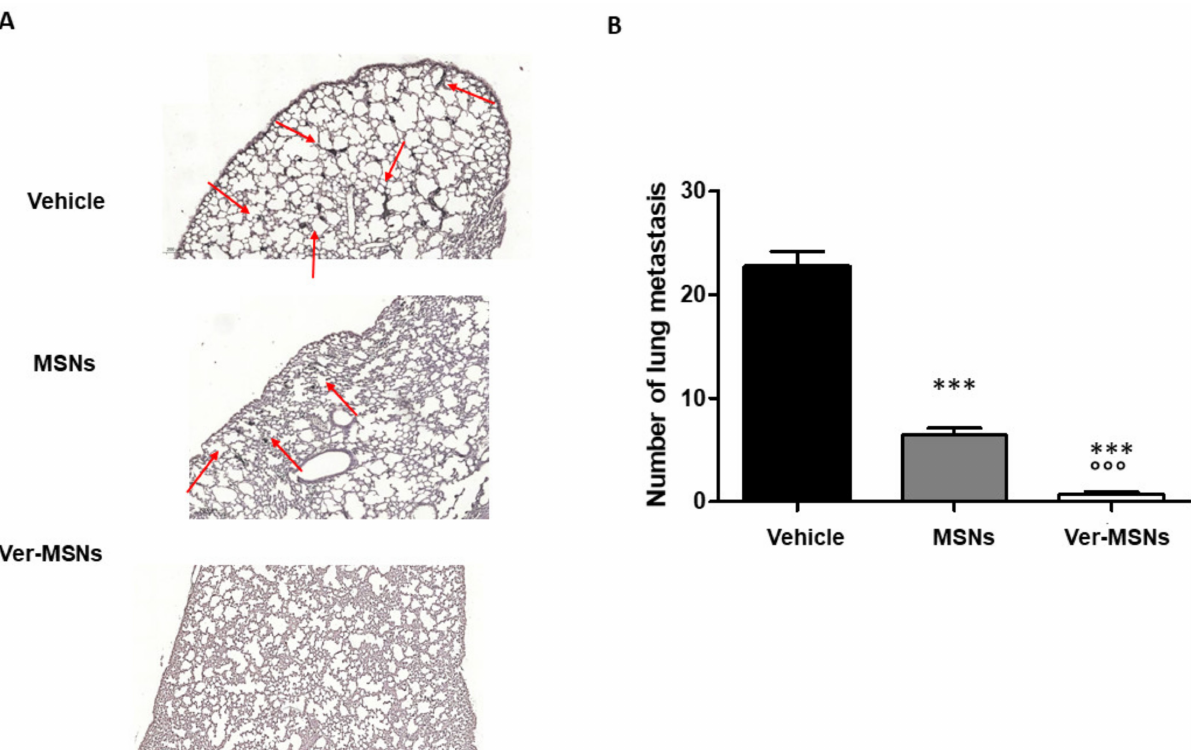
Figure 3. Effect of Ver-MSNs on the metastasizing ability to colonize the lung of B16-F10 tumors in C57BL/6J mice. ( A ) Immunohistochemical staining on lung anti-Triple M. Positive metastasizing nodules in the lung parenchyma are indicated by arrows. Bar = 200 µ m. ( B ) Quantification of metastasis numbers counted in at least 10 different fields. The high number of metastasizing mass occurring in control lungs is strongly reduced following the MSN treatment and almost abolished following Ver-MSN treatment. A one-way ANOVA test and Dunnett’s multiple comparisons test were used to compare differences in the treatments. *** p < 0.0001 vs. vehicle. ◦◦◦ p < 0.0001 vs.